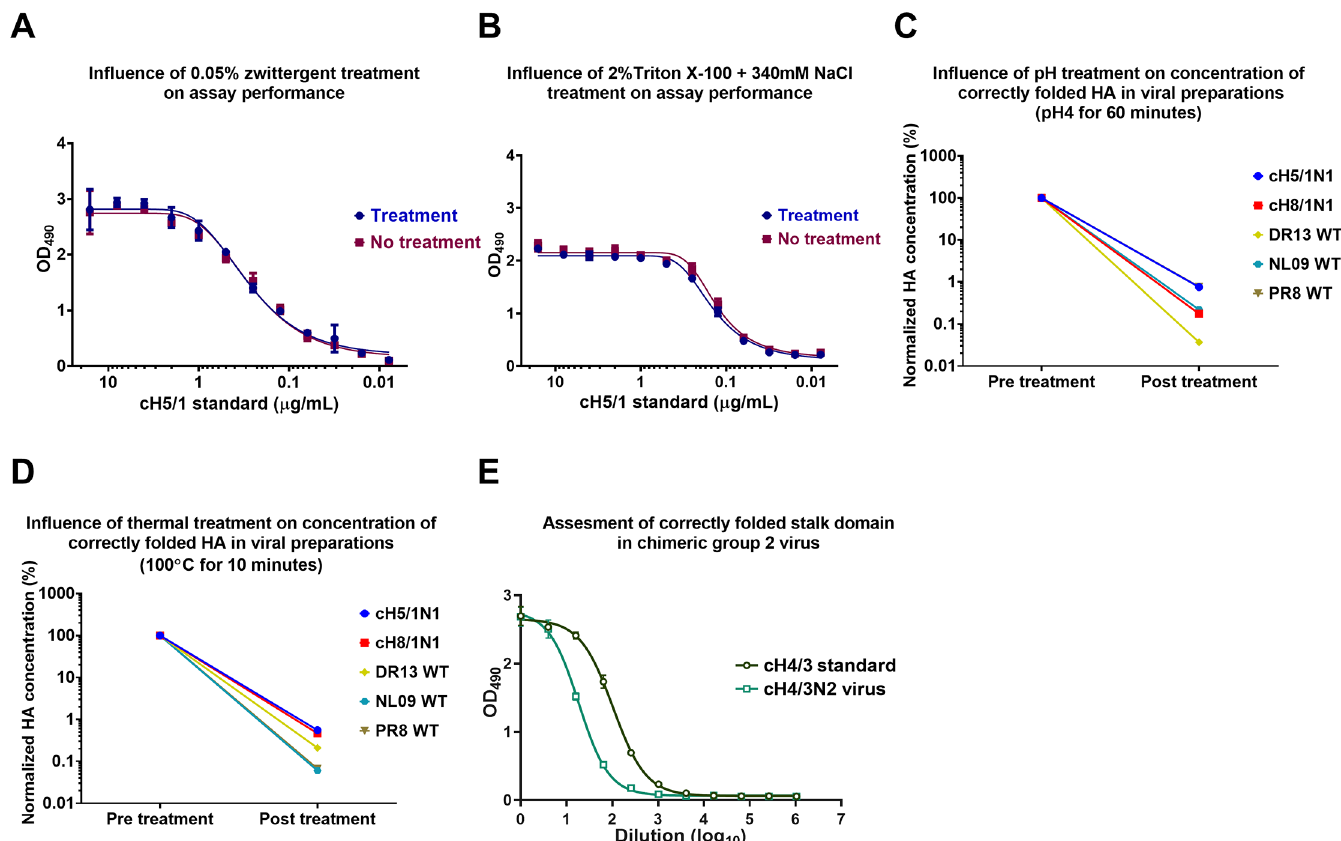
Fig 3. Effect of different stress treatments and group 2 stalk on assay performance. Detergent treatment is necessary for the assay for optimal access antigenic sites on the HA trimers. In addition, conditions during the vaccine production process also require detergent and high salt concentrations. To test if these conditions influence the stalk conformation we treated recombinantly expressed HA protein (which is used as standard in the assay) with (A) 0.05% zwittergent and (B) 2% Triton X-100+340mM NaCl and compared the readout to the signal obtained with untreated HA. In addition, we tested the influence of different treatments on the concentrations of properly folded HA in purified viral preparations. We exposed the viral preparations to (C) low pH (pH 4 for 60 minutes) or (D) heat (100˚C for 10 minutes) treatment. Post treatment HA concentrations were normalized to pre-treatment concentrations. (E) A capture ELISA was performed to measure the HA content of a group 2 cHA expressing virus, cH4/3N2, with a recombinant cH4/3 protein as standard.